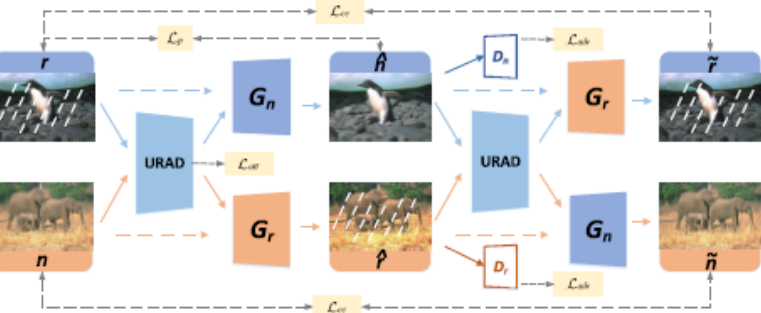
Figure 1. Schematic of the DerainCycleGAN method by Wei et al. [66]. The model follows the CycleGAN regime and employs URAD (Unsupervised Rain Attentive Detector) modules to attend to rain information and guide intermediate data